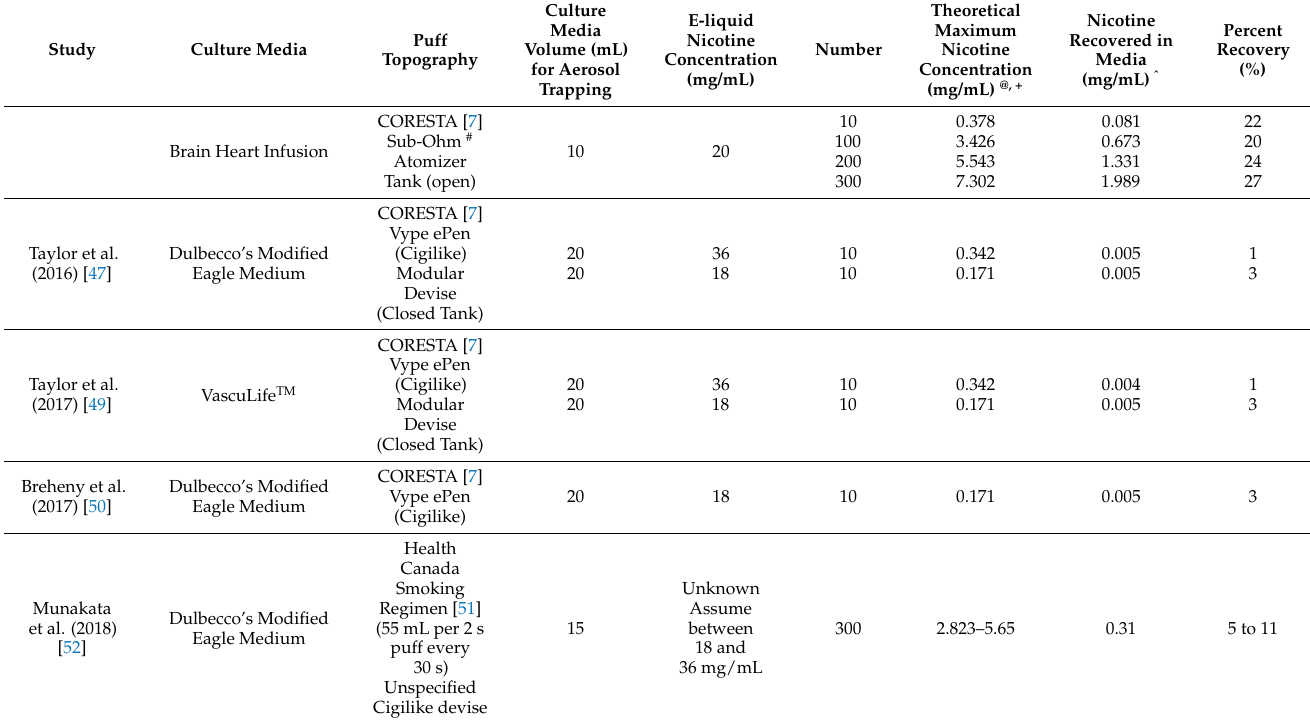
Table 6. Comparison of Nicotine Recovery in Culture Media Using Bubble-through